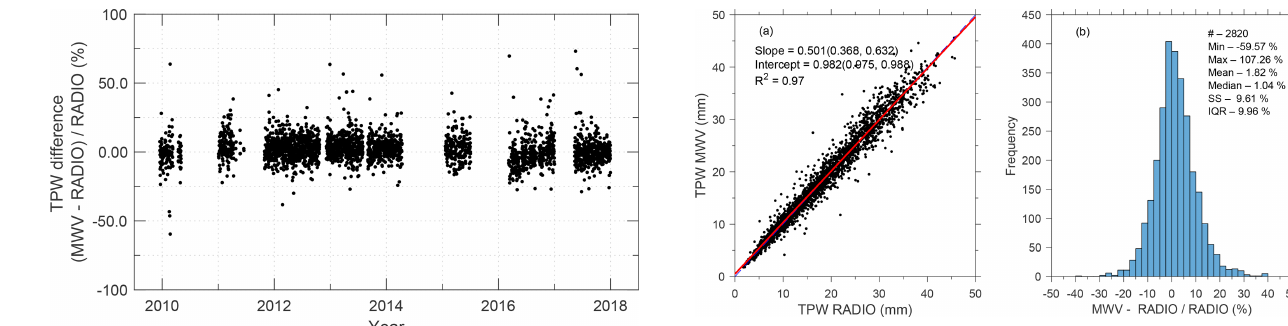
Figure 6. Time series of the relative difference (%) between the TPW from the microwave radiometer and the radiosonde during the period 2009–2017.